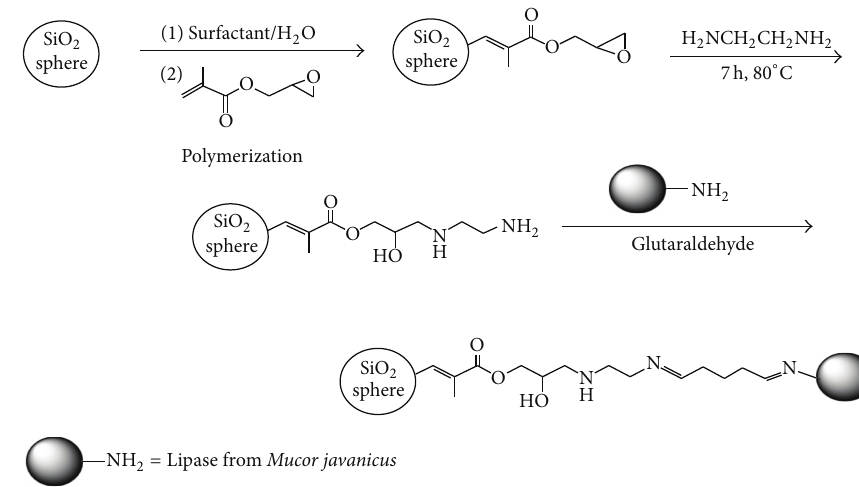
Figure 3: Lipase immobilization on silica